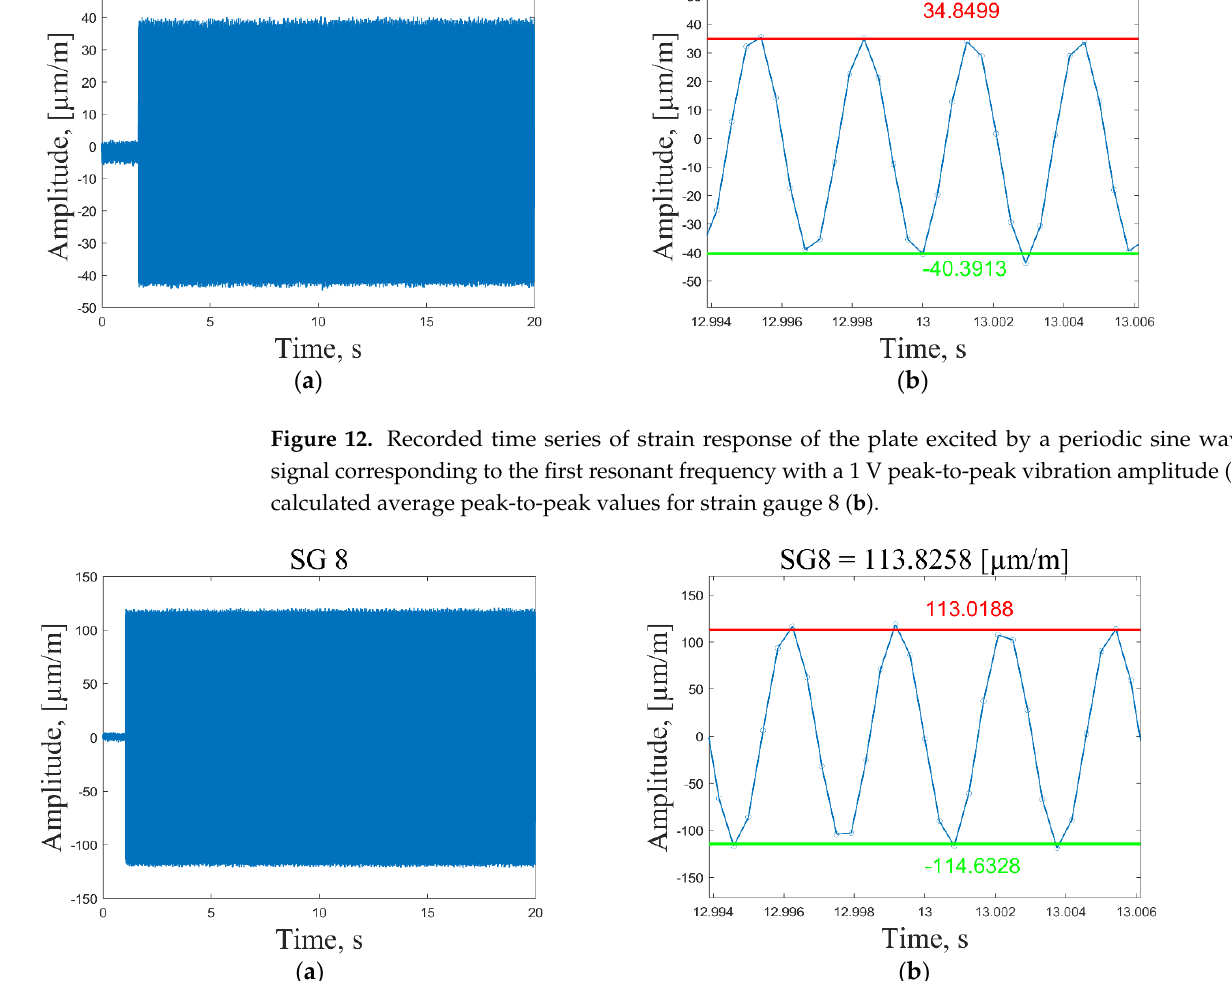
Figure 13. Recorded time series of strain response of the plate excited by a periodic sine wave signal corresponding to the first resonant frequency with a 3 V peak-to-peak vibration amplitude ( a ); calculated average peak-to-peak values for strain gauge 8 ( b ).